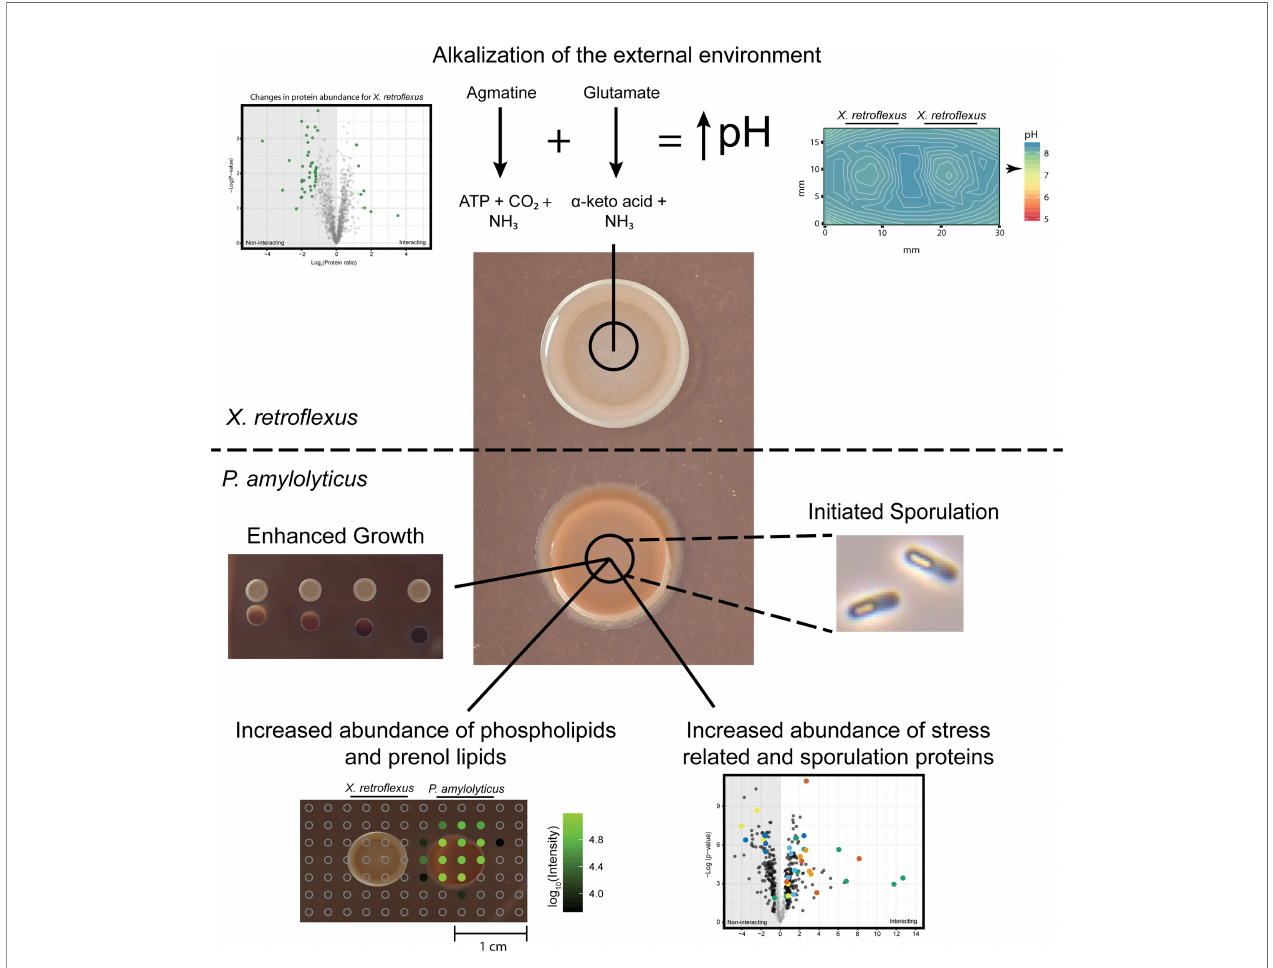
FIGURE 7 | Schematic overview of fi ndings in the study and their relation to the applied techniques. X. retro fl exus was found to drive environmental pH through degradation of amino acid products. In response, the stabilized pH environment led to; i) enhanced growth of P. amylolyticus as identi fi ed by increased CFU counts, ii) a changed abundance of glycerophospholipids and prenol lipids in the colony of P. amylolyticus as observed from metabolomics, iii) a signi fi cantly increased abundance in stress and sporulation related proteins in P. amylolyticus , and fi nally iv) an initiated sporulation response by P. amylolyticus , observed by